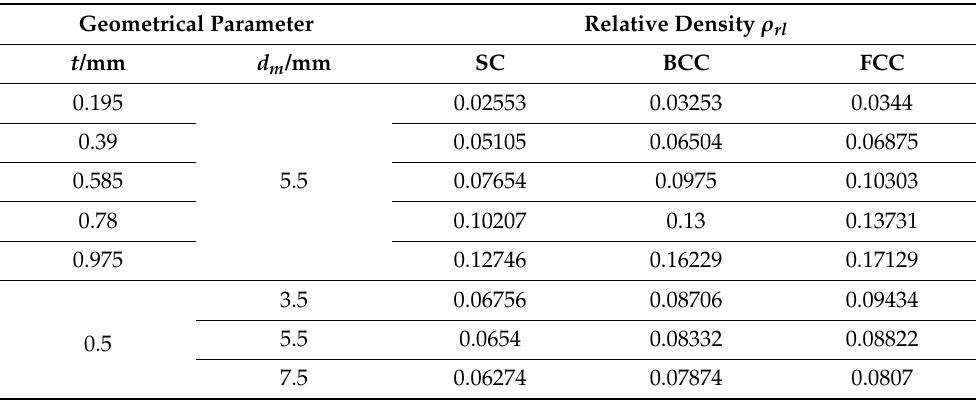
Table 1. Geometrical parameters and relative densities.